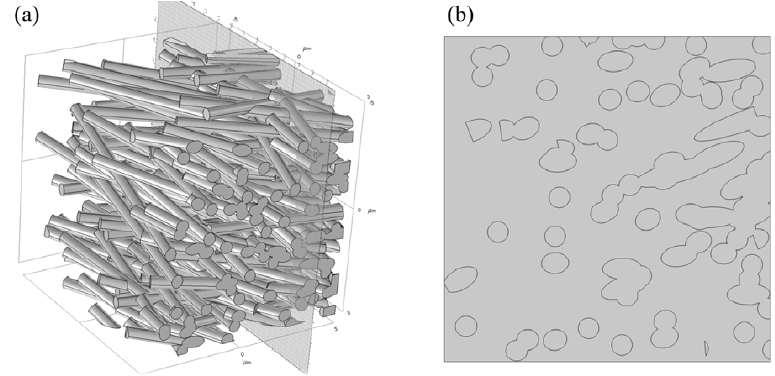
Figure 3. The designed model for simulation of imiquimod release profile: ( a ) the 225 cylindrical fibres randomly generated in a cubic; ( b ) the setting cross section of the designed